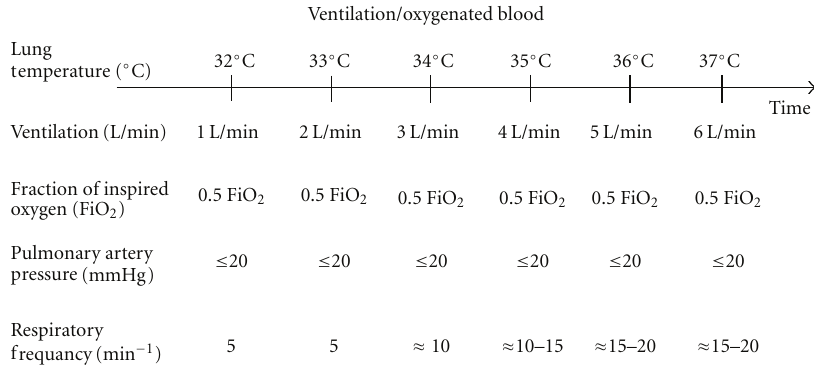
Figure 4: Flowchart illustrating the evaluation of ex vivo reconditioned lungs for clinical transplantation. During the evaluation, the lung is fully ventilated and the perfusate blood is deoxygenated. The gases entering the oxygenator are mixed to obtain values of pCO 2 of 4.5–5 kPa. At this point, the perfusion flow was 4–6L/min (i.e., full flow). Samples of the perfusate blood are taken before and after passing through the lung (i.e., venous and arterial blood samples) after 5 minutes’ exposure to FiO 2 of 0.21, 0.5, and 1.0 in order to measure blood gases. A deflation test is then performed. If the deflation test is normal and the PaO 2 with FiO 2 = 1.0 was 50 kPa or higher, the lungs are accepted for transplantation.